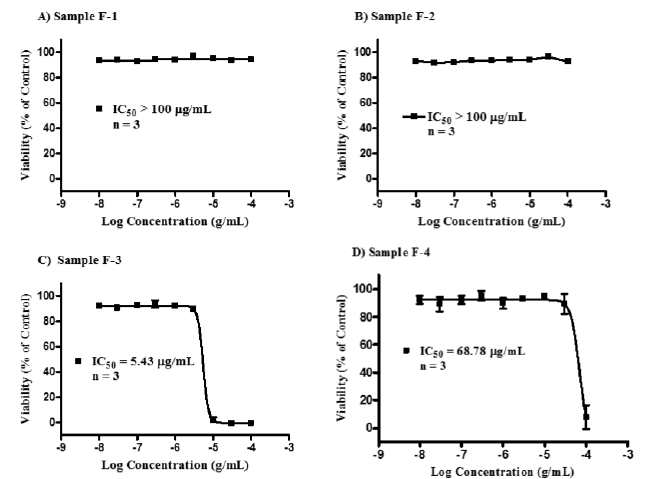
Figure 1. Cytotoxicity of the bee venom sample fractions F-1–F-4 against U937 cells. Fraction samples F-1 ( A ) and F-2 ( B ) were non-cytotoxic, each with an IC 50 value >100 μ g/mL. Fraction sample F-3 ( C , melittin) was the most cytotoxic with an IC 50 of 5.43 (95% CI 4.43–6.66) µg/mL, while fraction sample F-4 ( D , lipid) had an IC 50 value of 68.78 µg/mL.